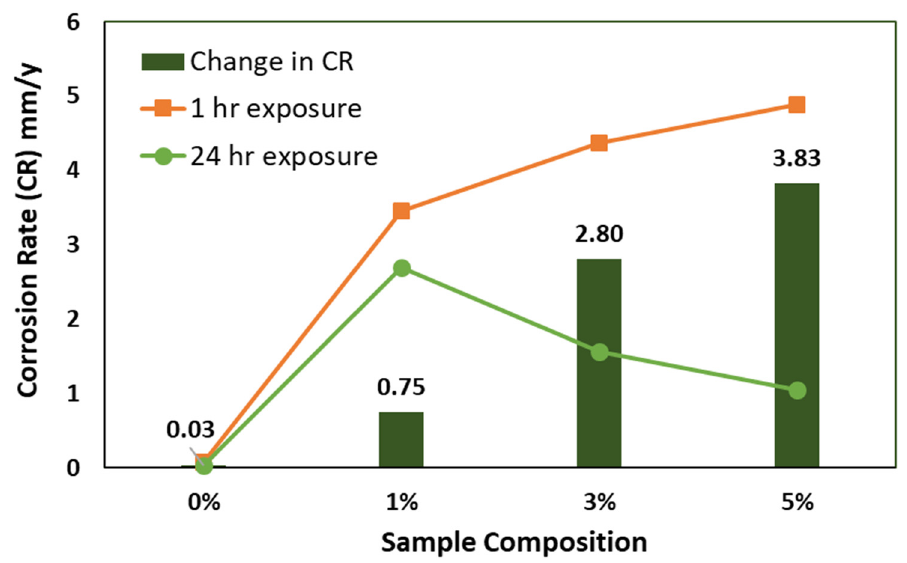
Figure 11. Graphical representation of corrosion rate (CR) after 1 h and 24 h exposure to NaCl solution.